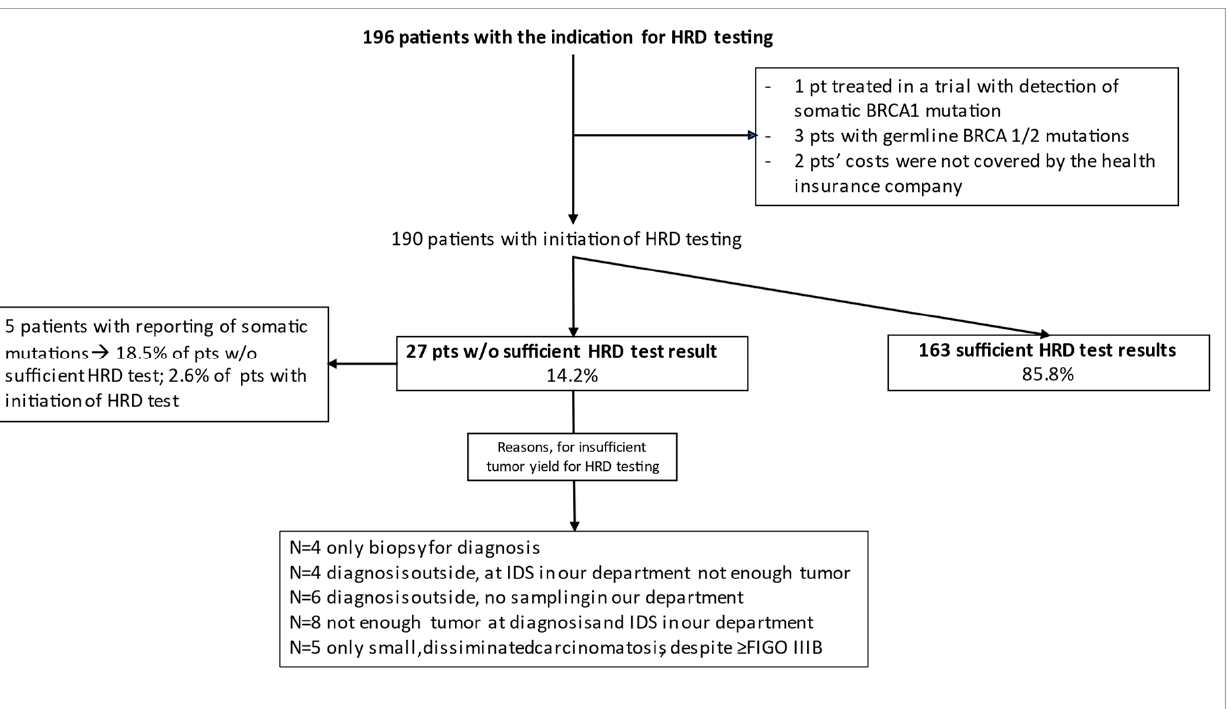
Figure 1. Flow chart of patients with the indication for HRD testing and final results. HRD represents homologous recombination deficiency; IDS represents interval debulking surgery.